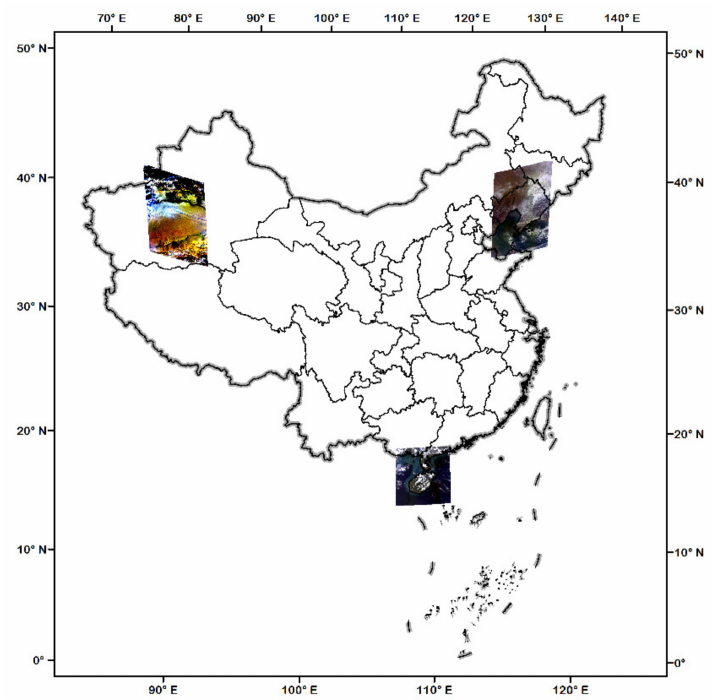
Figure 1. The locations of the test images of the Hainan, Liaoning, and Xinjiang areas in